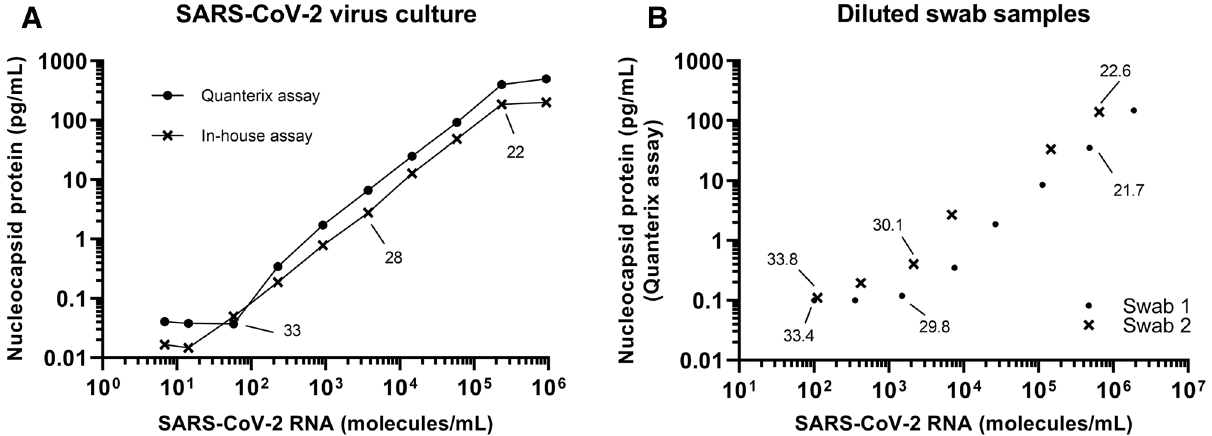
Figure 2. ( A ) A fourfold dilution of SARS-CoV-2 virus culture was analyzed using the Quanterix assay and the in-house assay. Nucleocapsid protein concentration against SARS-CoV-2 virus culture measured using ddPCR is shown. Real time RT-PCR Ct-values are presented. ( B ) Two real time RT-PCR SARS-CoV-2 positive swab samples were diluted using a fourfold dilution. Each dilution was analyzed for nucleocapsid protein using the Quanterix assay and for SARS-CoV-2 RNA using both real time RT-PCR and ddPCR. Real time RT-PCR Ct-values are ecules/mL. Every dilution was measured with both the in-house assay and the Quanterix assay (Fig. 2A). Using the LOD concentrations the in-house assay can detect a protein concentration corresponding to 20 RNA mol- ecules/mL and the Quanterix assay 100 RNA molecules/mL. A technical sensitivity equivalent to 20–100 RNA molecules/mL is also found when estimating from Fig. 2A. The upper level of detection was 10 5 RNA molecules/ mL in both assays estimated from Fig. 2A. The technical sensitivity was further examined by preparing two real time RT-PCR positive swab samples in various dilutions and measuring using the Quanterix assay, ddPCR, and real time RT-PCR (Fig. 2B). Estimated from Fig. 2B the number of RNA molecules/mL were 2000 and 100 for swab 1 and 2, respectively. The upper level of detection was estimated to be 10 6 RNA molecules/mL. Concentrations of SARS‑CoV‑2 nucleocapsid antigen in real time RT‑PCR negative and posi‑ tive samples. SARS-CoV-2 nucleocapsid antigen was measured in 73 real time RT-PCR negative samples and 148 real time RT-PCR positive samples using Quanterix assay (Fig. 3). Out of these samples there was enough material in 118 real time RT-PCR positive and 73 real time RT-PCR negative for quantifying SARS- CoV-2 nucleocapsid antigen using the in-house assay. The Ct-values of the positive samples were between 12.6 and 35.1 (median 20.5). For each sample, the signal coming from the helper beads was subtracted the concentra- tion of the antigen beads which improved discriminating the positive from the negative samples. This procedure resulted in reported concentrations below assay LOD for a few samples. Samples with a concentration above the